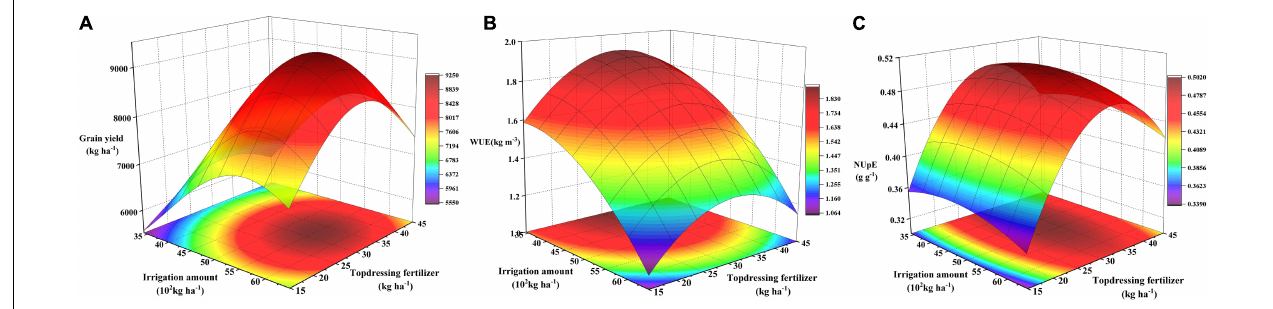
FIGURE 3 | Relationships among water and nitrogen input and grain yield (A) , water use efficiency (WUE, B) , and N uptake efficiency (NUDE, C) of japonica rica.